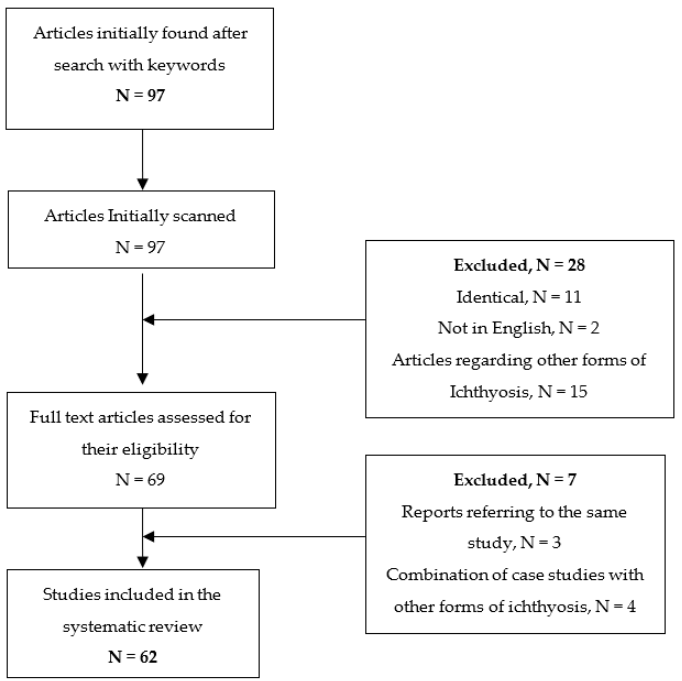
Figure 1. PRISMA flowchart of the selection of the